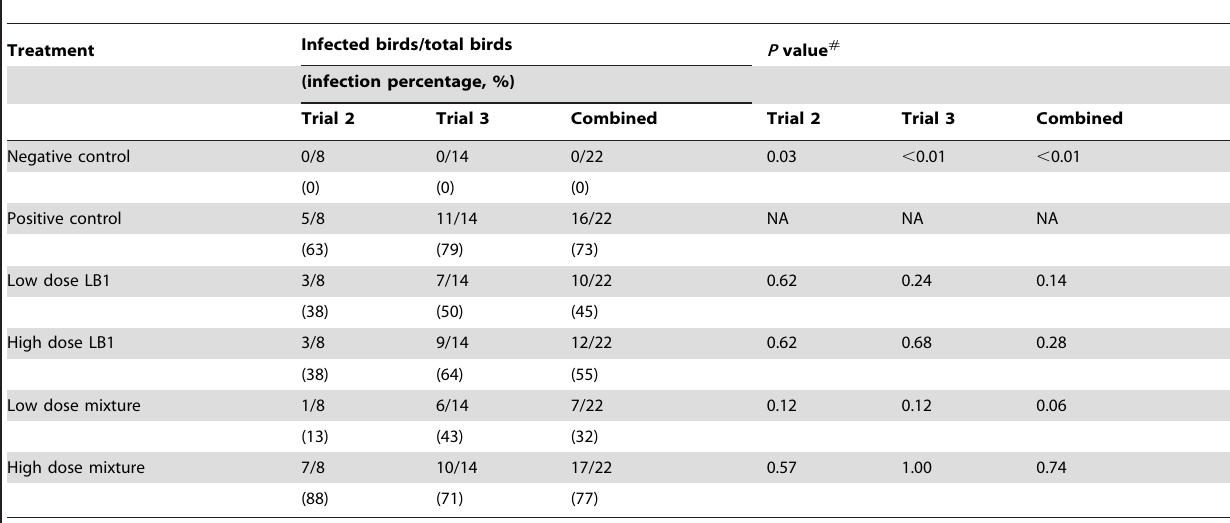
Table 5. Salmonella invasion to the spleen on days 3 and 4 post-infection * .